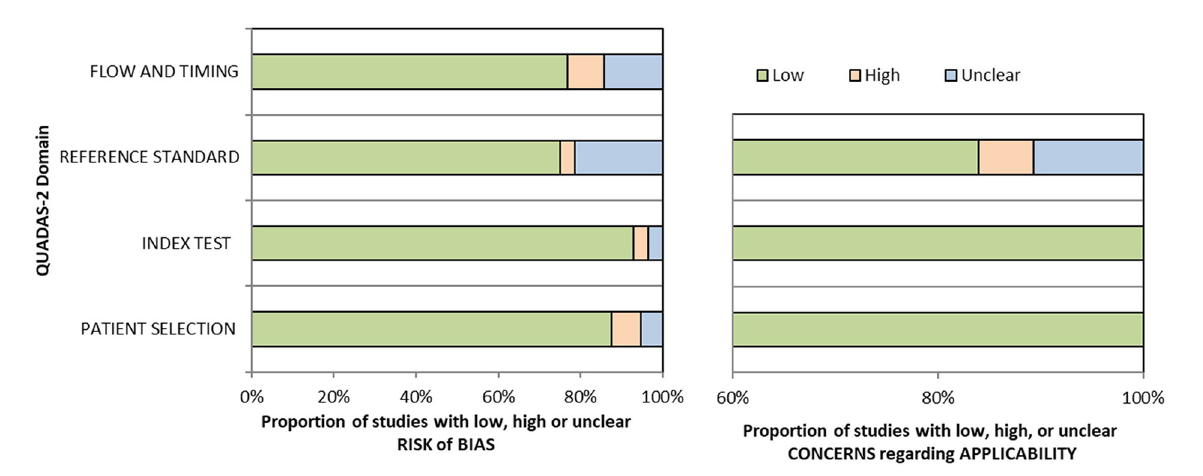
(SMD) method for pooling continuous outcomes in